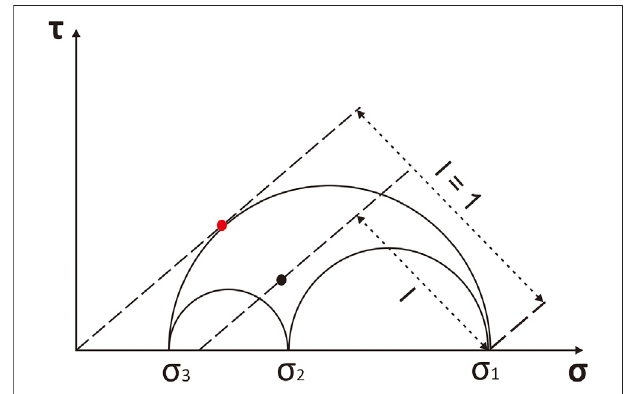
FIGURE2| Faultinstabilityde fi nition[modi fi edfromVavry ˇ cuk(2011)and Vavry ˇ cuk et al.